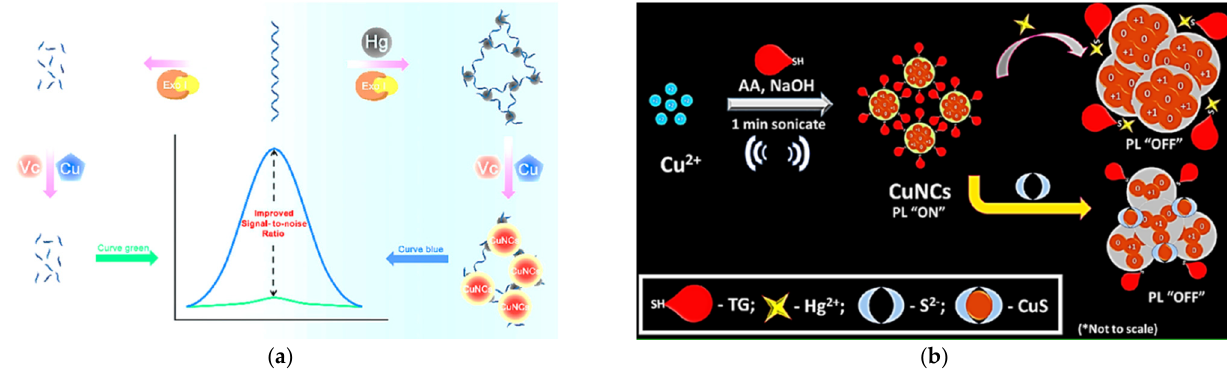
Figure 3. ( a ) Schematic Illustration of Hg 2+ Quantification Based on Fluorescence Regulation of CuNCs via DNA Template Manipulation; ( b ) Schematic representation for the possible mechanism of Hg 2+ and S 2 − detection using TG-CuNCs.